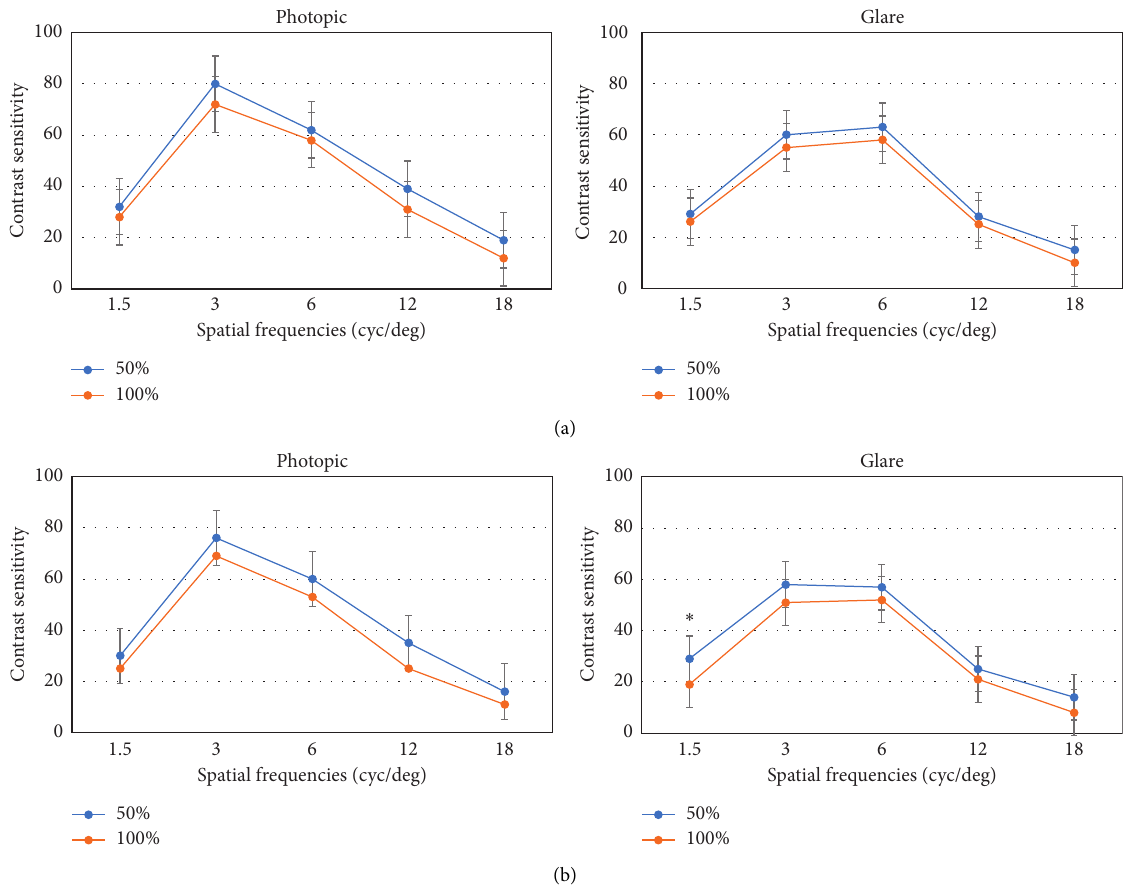
Figure 3: Comparison of postoperative contrast sensitivity between groups under photopic and glare conditions ((a) P-Dist < 0.220mm; (b) P-Dist > 0.220mm). ∗ P < 0 .